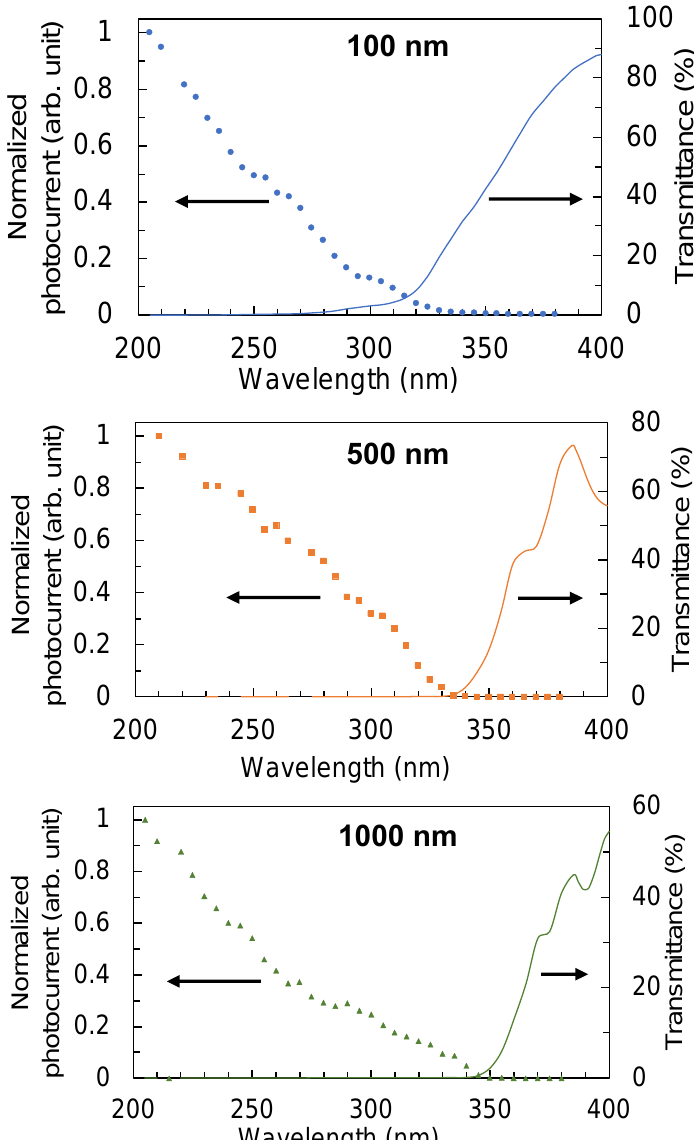
Figure 10. Wavelength response of the detectors with 100 nm, 500 nm, and 1000 nm film thicknesses. The cut-off wavelength is defined by the onset of a photocurrent being measured. The cut-off wavelength shifts to longer wavelengths as the thickness of the film increases, in accordance with the shift to longer wavelengths of the transmission and absorption edges. The photocurrents were corrected for the wavelength dependence of the excitation source.